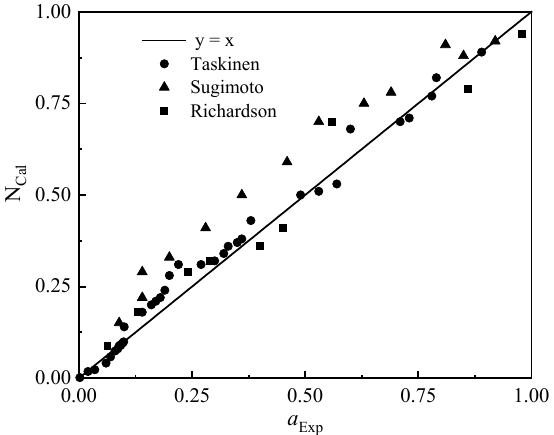
Figure 2. Comparison of ZnO mass action concentration calculations with activity measurements.